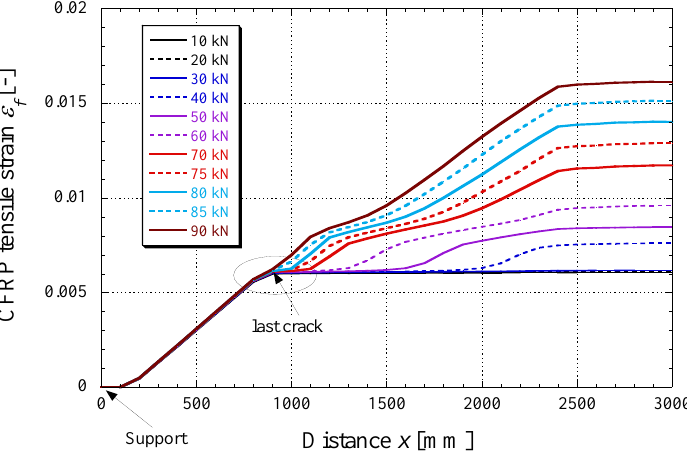
Figure 12. CFRP strain ε -distribution over the beam length as a function of the applied f force, F tot